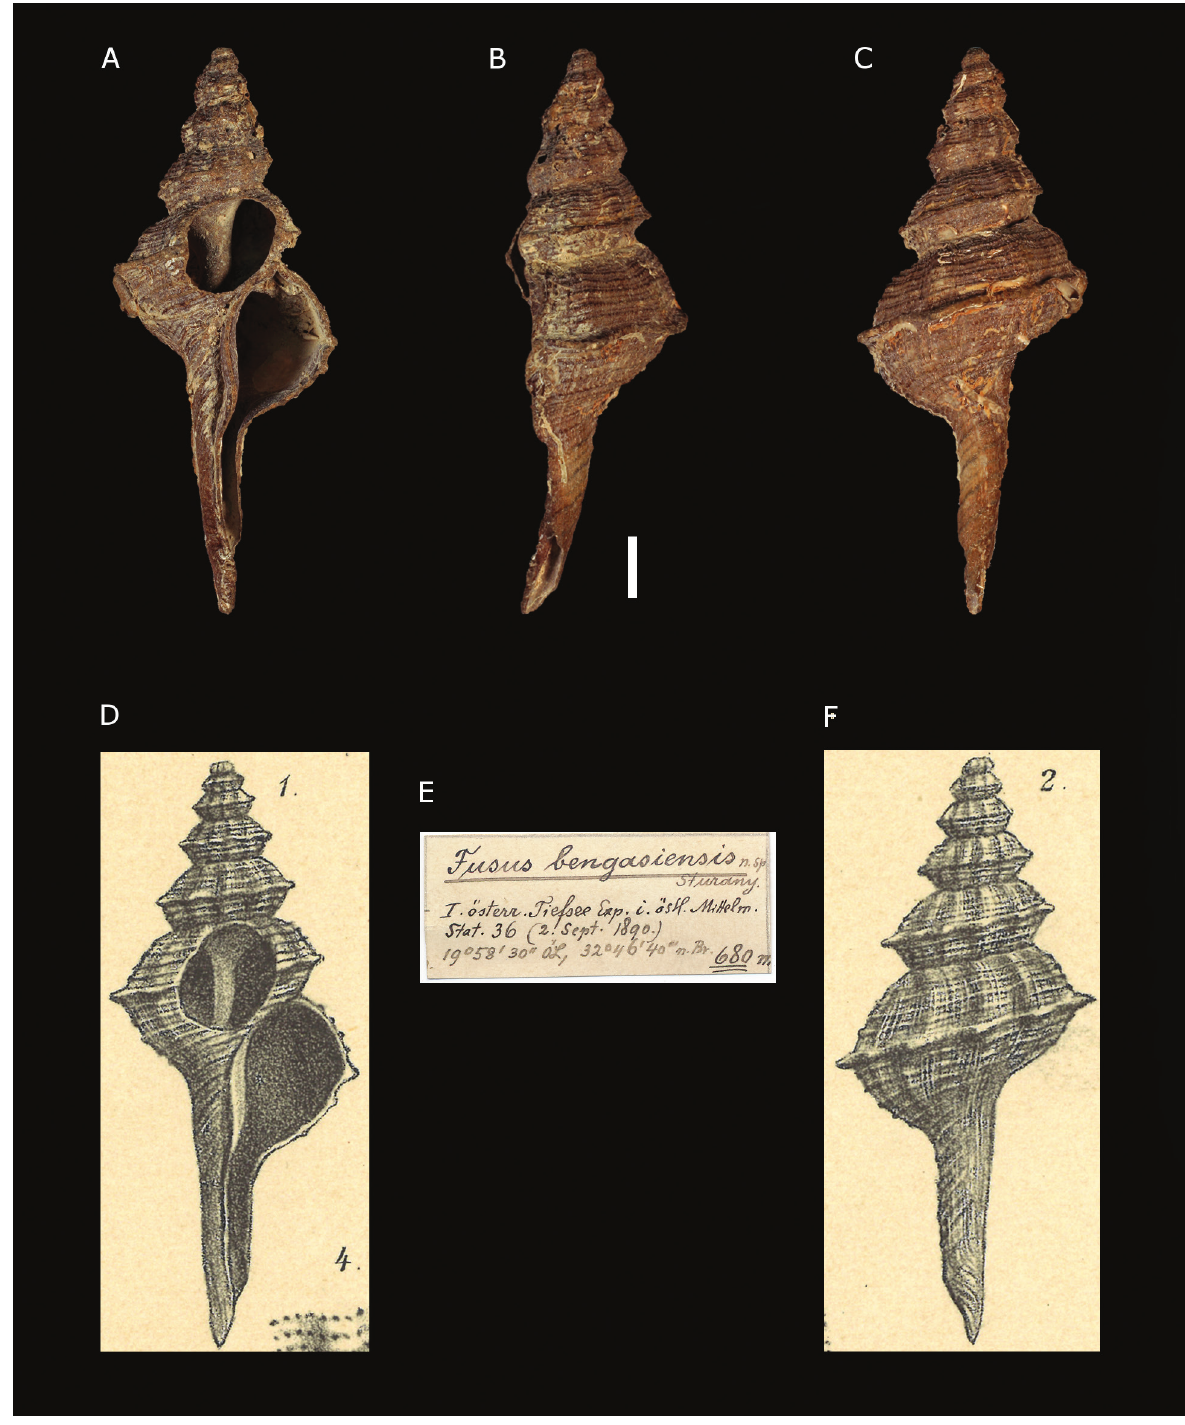
Figure 5. Fusus bengasiensis Sturany, 1896, Station 36, north of Benghazi, Libya. A–C . Holotype NHMW 13000: front ( A ), side ( B ), and back ( C ) views E . Original label. D , F . Original figures in Sturany, 1896. Scale bar: 5 mm.